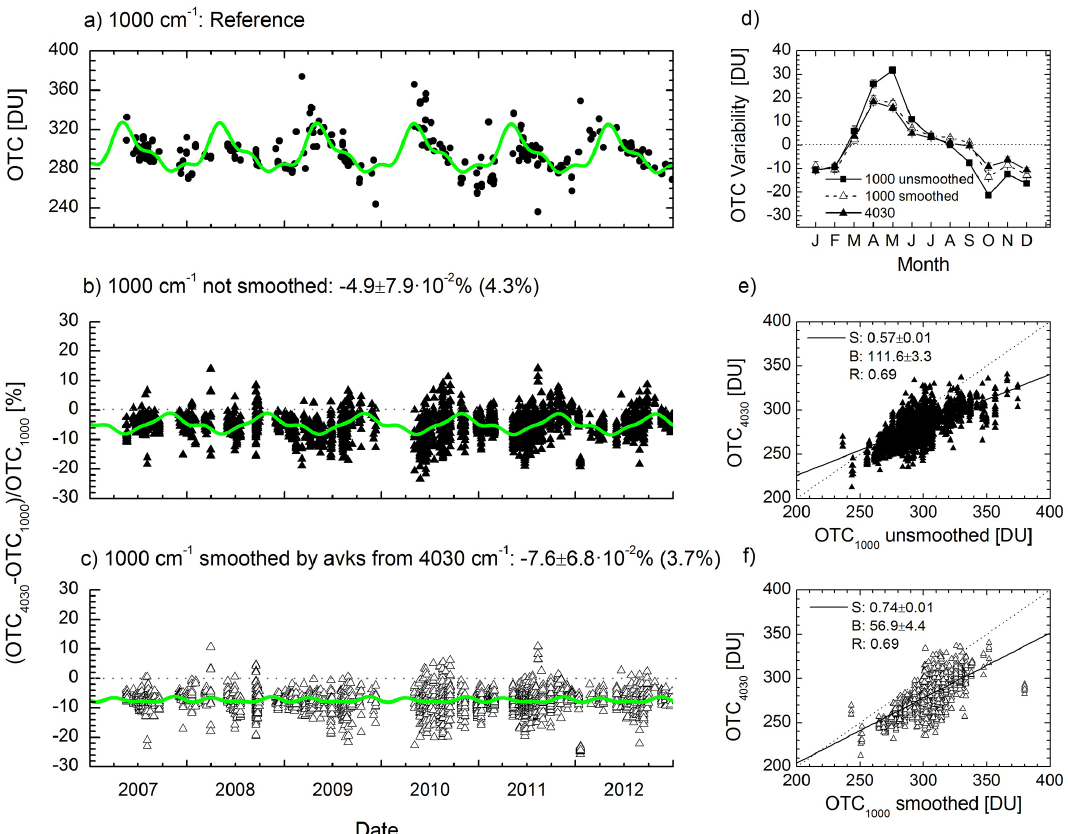
Figure B1. Same as Figs. 4, 5, and 6, but for OTC obtained from TCCON spectra in the 4030cm − 1 region (InGaAs detector, spectral resolution of 0.02cm − 1 , N =